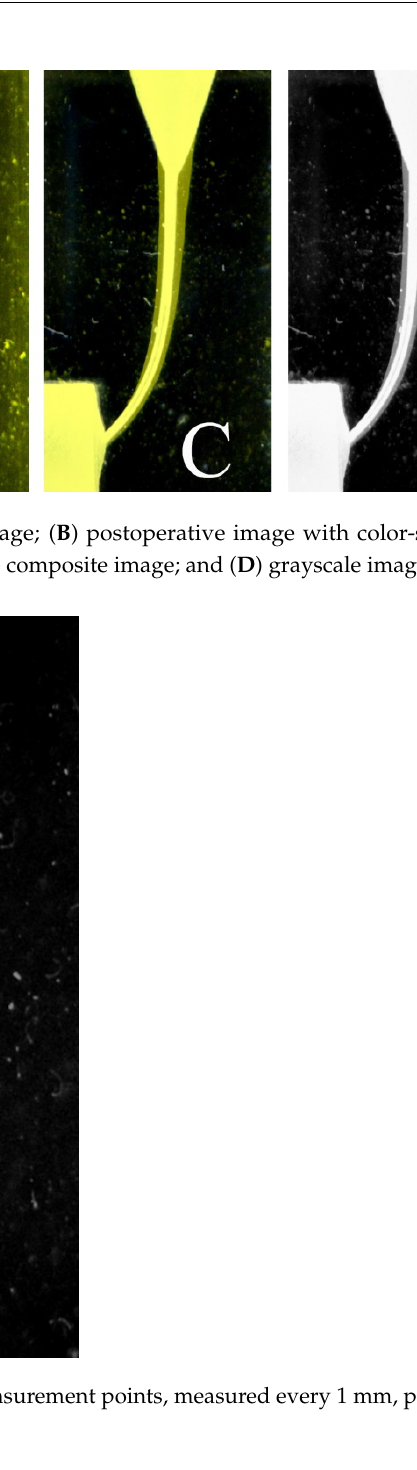
Figure 2. Illustration of the measurement points, measured every 1 mm, perpendicular to the axis of the duct.